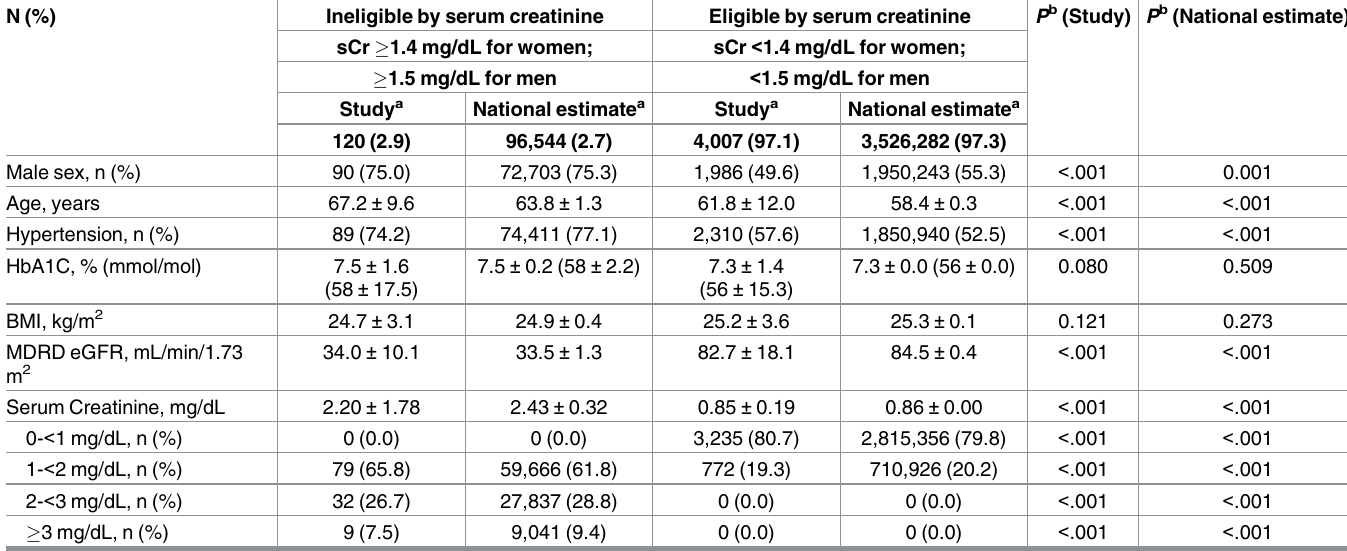
Table 1. Baseline characteristics of total study population according to metformin eligibility by sCr level, KNHANES